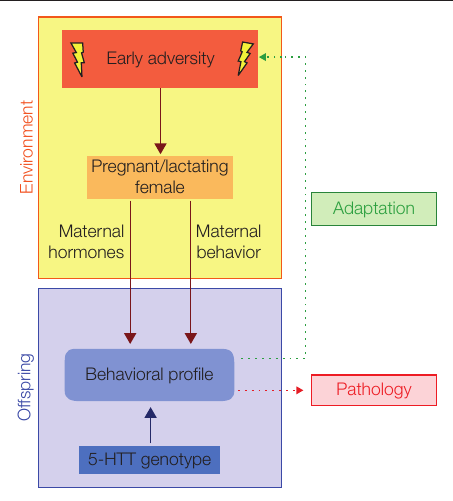
Figure 2 | The shaping of behavioral profile by early adversity. Through influencing maternal hormones and maternal behavior early adversity shapes offspring behavioral profile. This process is modulated for instance by the 5-HTT genotype and in principle adjusts the offspring to environmental conditions of adversity (adaptation). An impaired 5-HTT expression, however, increases the risk of emotional disorders (pathology). Notably, a direct influence of early adversity on the offspring, as well as the possible role of father, siblings, or the whole social group is not considered in this schema. Changed after Sachser et al.